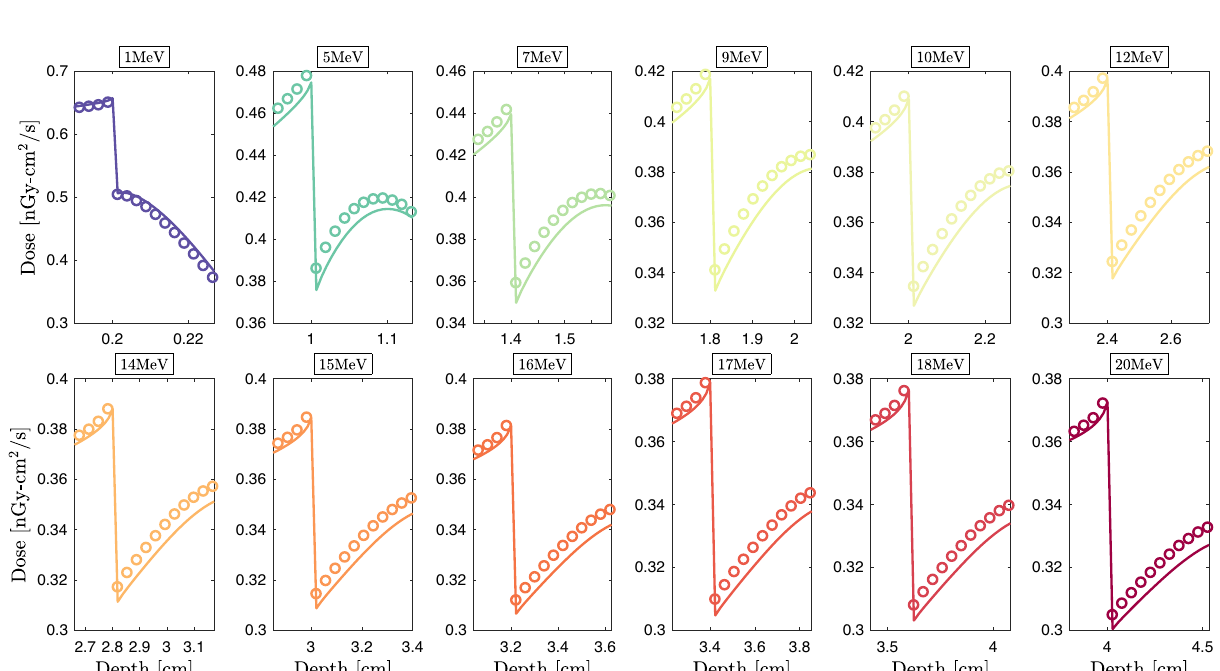
Figure 4. Njoy-Dragon-5 depth-dose curves ( solid lines ) compared to Geant-4 [ G4EmLivermore ( circles )] for incident unidirectional electron beams around the tumor [ left ] -aluminium [ right ] transition in the IORT- benchmark. Dimensions are fixed to the incident beam’s range. MC convergences are obtained for a 0.2% mean standard